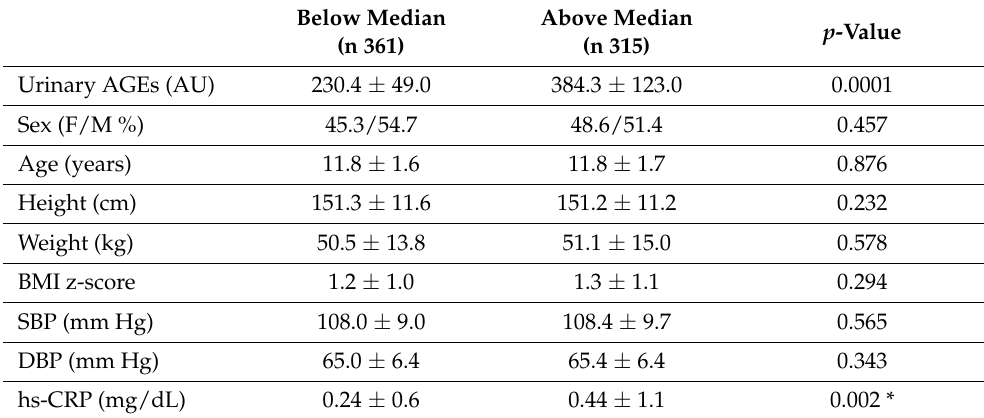
Below Median Above Median p -Value (n 361) (n 315)